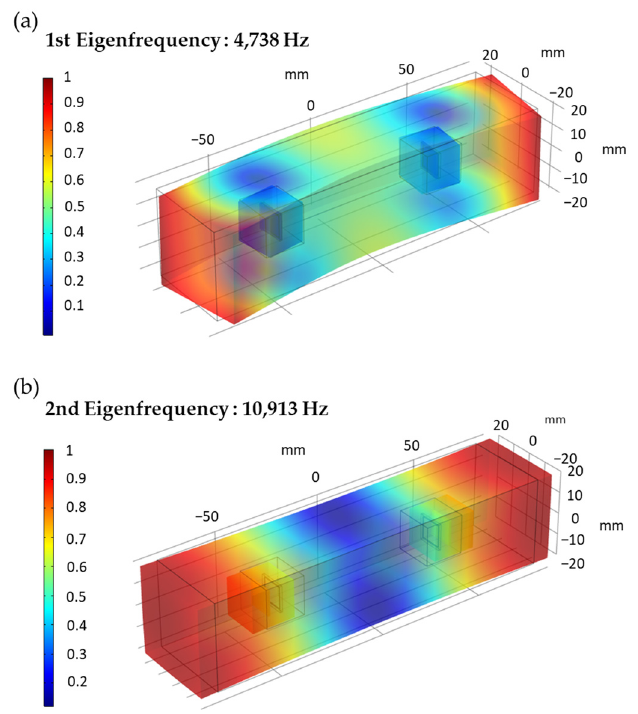
Figure 7. Finite element simulation of specimen eigenfrequency: ( a ) Modal displacement with 1st eigenfrequency of P.S 32.5; ( b ) Modal displacement with 2nd eigenfrequency of P.S 32.5.